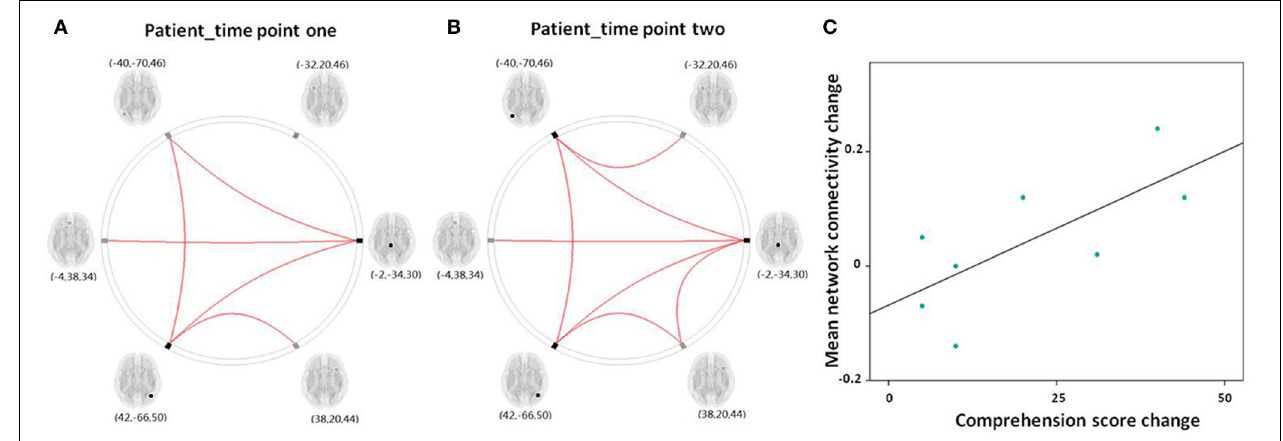
FIGURE 6 | (A,B) Graphical presentation of the left frontoparietal network in aphasic patient in time point one and two separately identified by network connectivity analysis analysis. A threshold of FDR-corrected P < 0 . 05 was